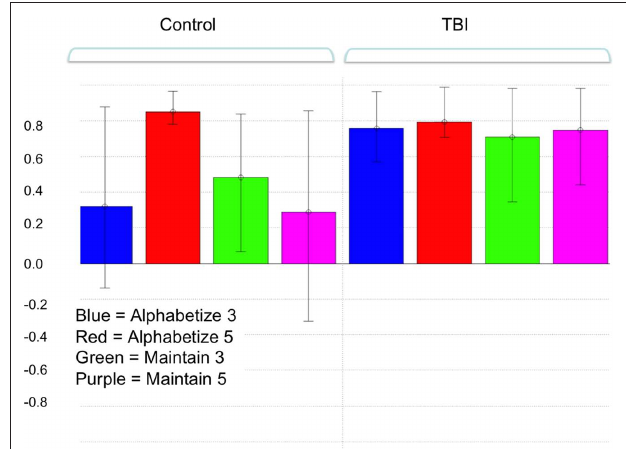
FIguRe 1 | Pattern of brain and behavioral correlations for the first latent variable (LV) in the combined group analysis. This LV accounted for the greatest magnitude of matrix variance (LV 1, p < 0.01). Colored bars denote the extent to which the experimental conditions relate to the differences in voxel signals represented in the LV (i.e., the design saliences). Error bars denote confidence intervals defined by the standard error of the bootstrap estimates. Error bars crossing zero reflect a non-significant contribution of that experimental condition to the LV pattern. Significant voxel clusters associated with this LV are presented in Table 1